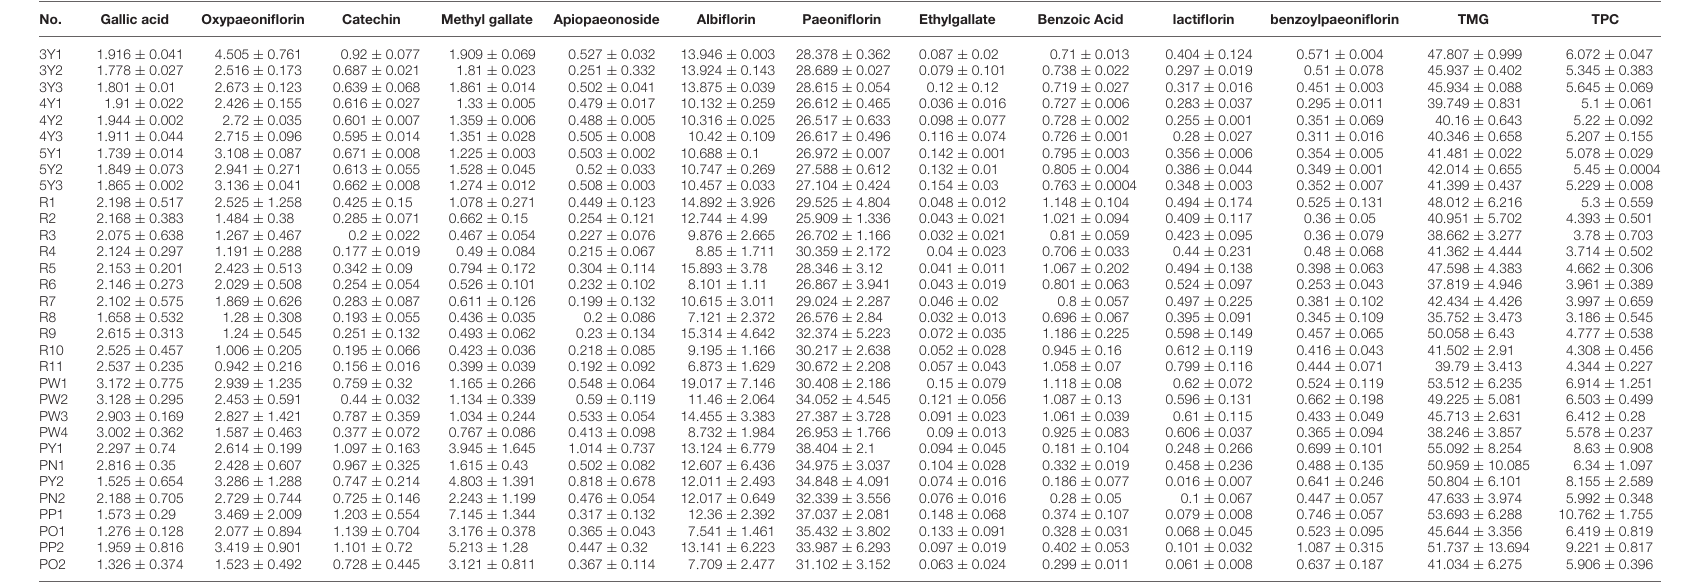
TMG, total content of five monoterpene glycosides; TPC, total content of six phenols; 3Y, 3-year-old roots of P. lactiflora; 4Y, 4-year-old roots of P. lactiflora; 5Y, 5-year-old roots of P. lactiflora; R, samples of different diameters; PW, whole roots with “pockmarks”; PY1, divided roots with old formed “pockmarks”; PN1, divided roots without old formed “pockmarks”; PY2, divided roots with newly formed “pockmarks”; PN2, divided roots without newly formed “pockmarks”; PP, parts with “pockmarks” of the longitudinally cut root; PO, parts without “pockmarks” of the longitudinally cut